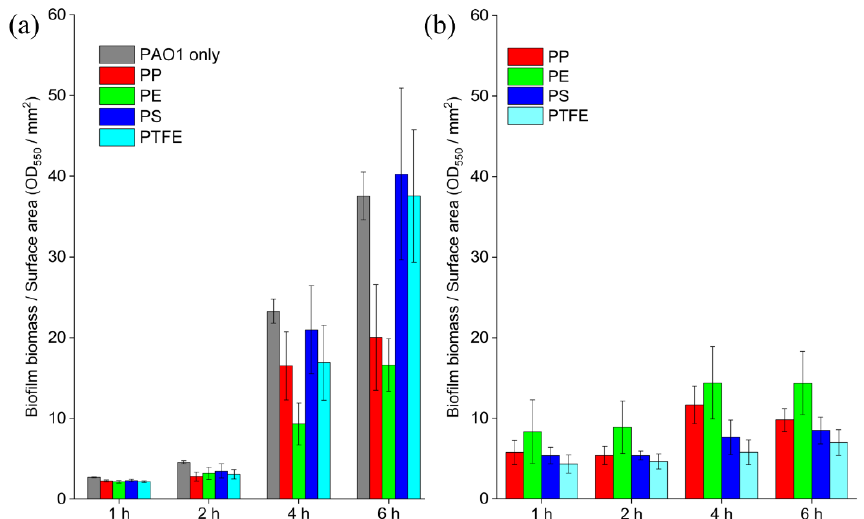
Figure 4. ( a ) Biofilm formation on the well surface. ( b ) Biofilm formation on the microplastic sur- face. Error bars were defined as standard deviations (n = 6, biological